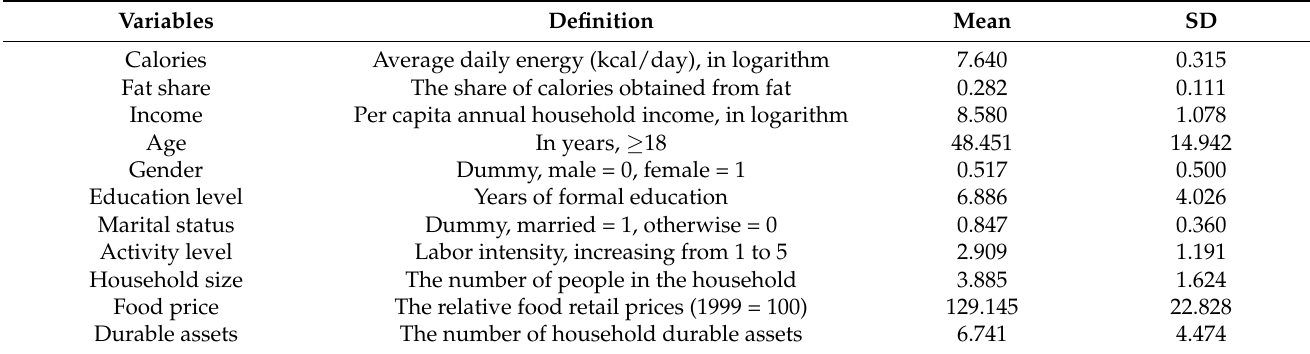
Table 1. Descriptive statistics of